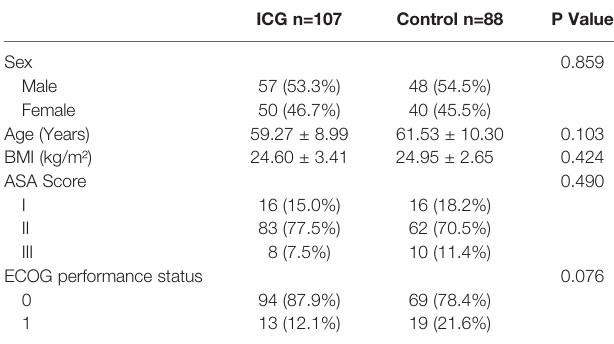
TABLE 1 | Baseline characteristics of ICG and control group.